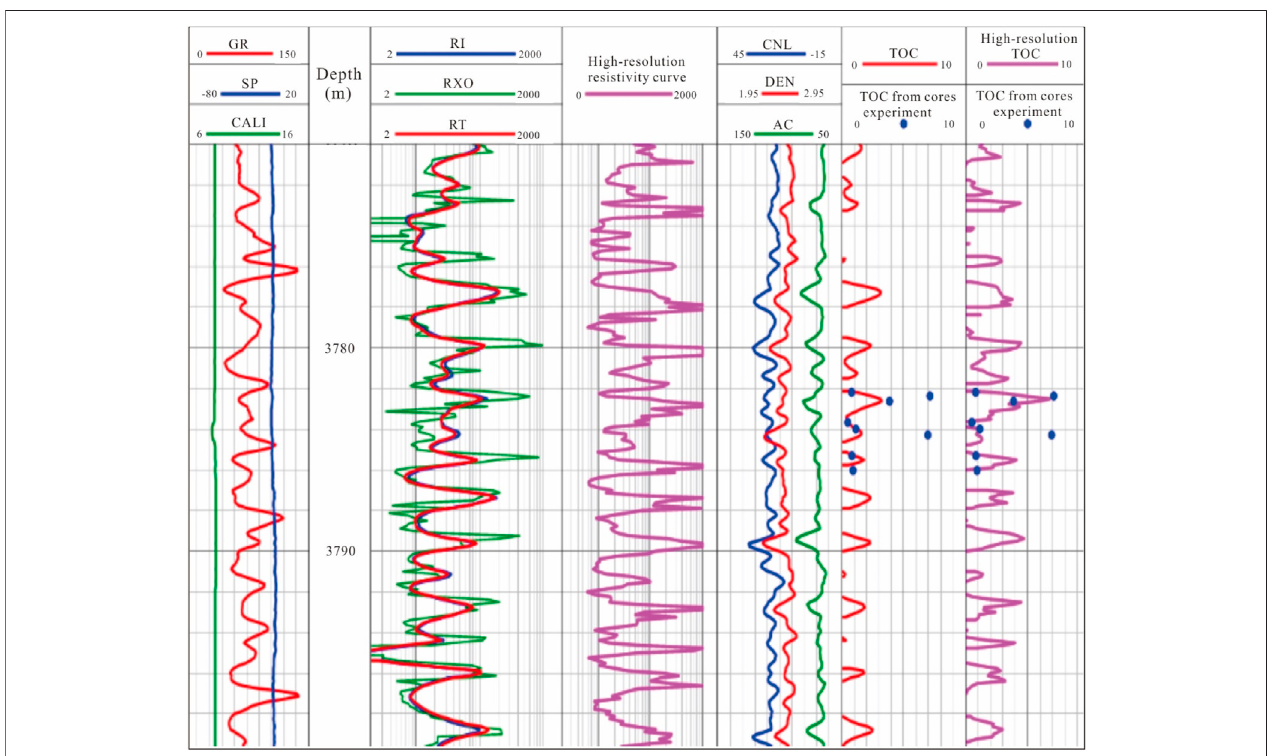
FIGURE 10 | Comparison chart of organic carbon calculated using conventional deep lateral resistivity and microresistivity scanning.